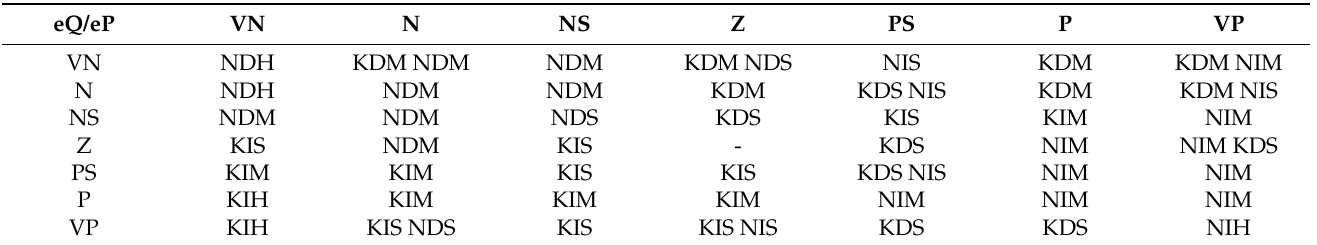
Table 2. Expert rules for the fuzzy controller according to defined fuzzy variables for inputs and